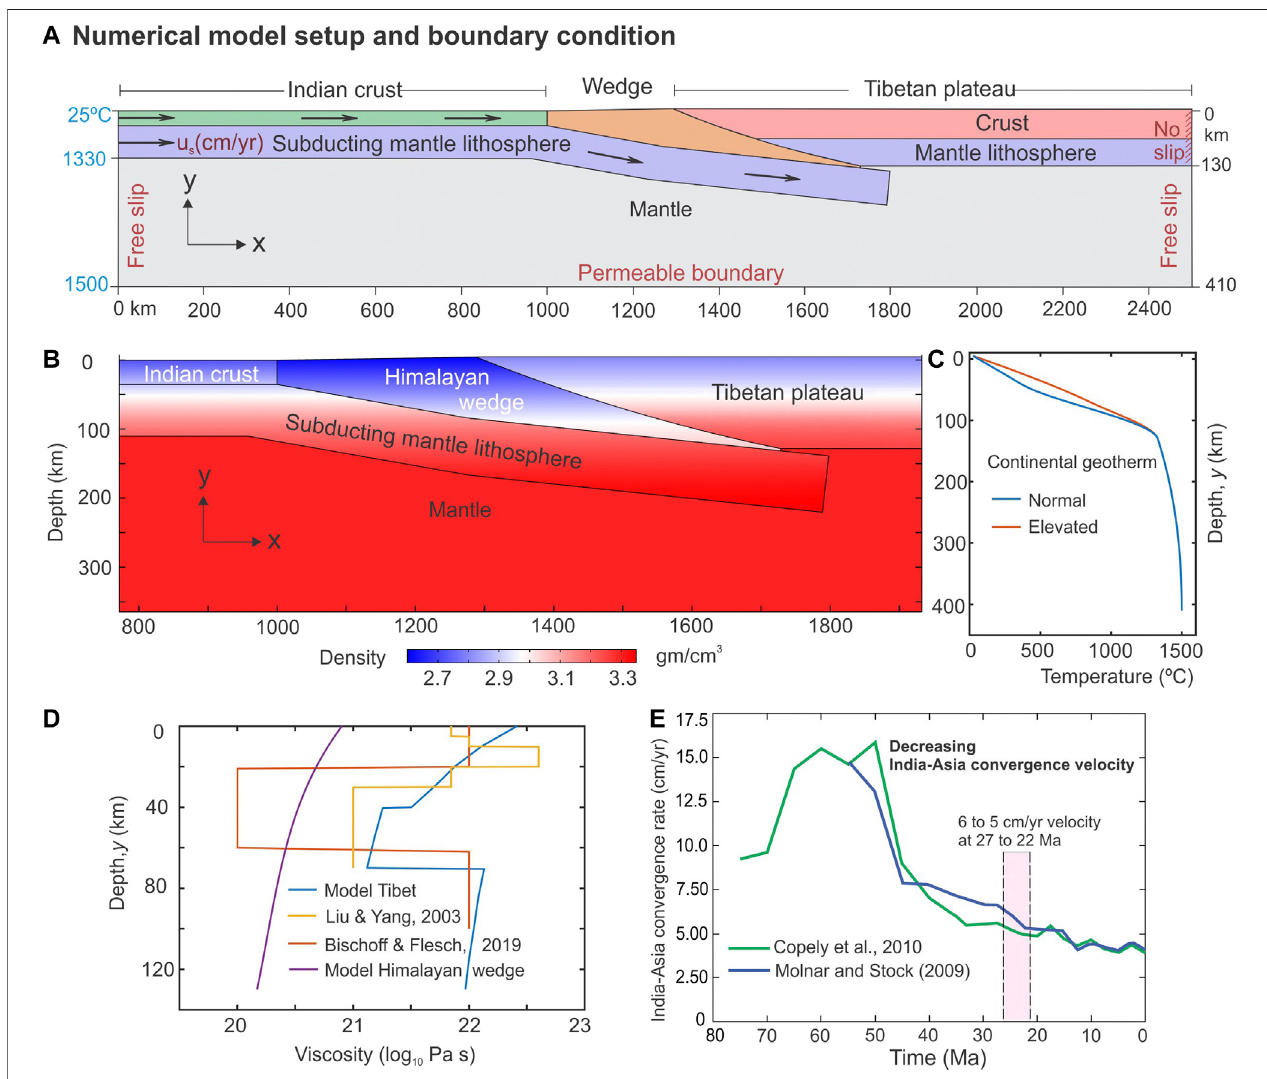
FIGURE 3 | (A) Numerical model setup with thermal and kinematic boundary conditions used for the simulations. (B) The density pro fi les in the reference model. NotethatwehaveconsideredmaterialsofrelativelylowerdensitytoconstitutethemodelHimalayanwedge.Thisisbasedontheresultsofearlierspontaneouslyevolved numerical models, suggesting that the wedge consists of crushed materials derived from upper and mid-crustal rocks, therefore buoyant compared to the lithospheric plates (Burov and Yamato, 2008; Warren et al., 2008; Li and Gerya, 2009). (C) A comparative plot of normal and elevated geotherm in the Himalaya-Tibet system. Duetothermalequilibriumandradioactiveheatproduction,thegeothermisconsideredtobeelevatedby20 Ma(Beaumontetal.,2001). (D) Theviscositypro fi lesforour model Tibet and Himalayan wedge have been plotted against previous studies for the same system. (E) Variation of India-Asia convergence velocity with time.